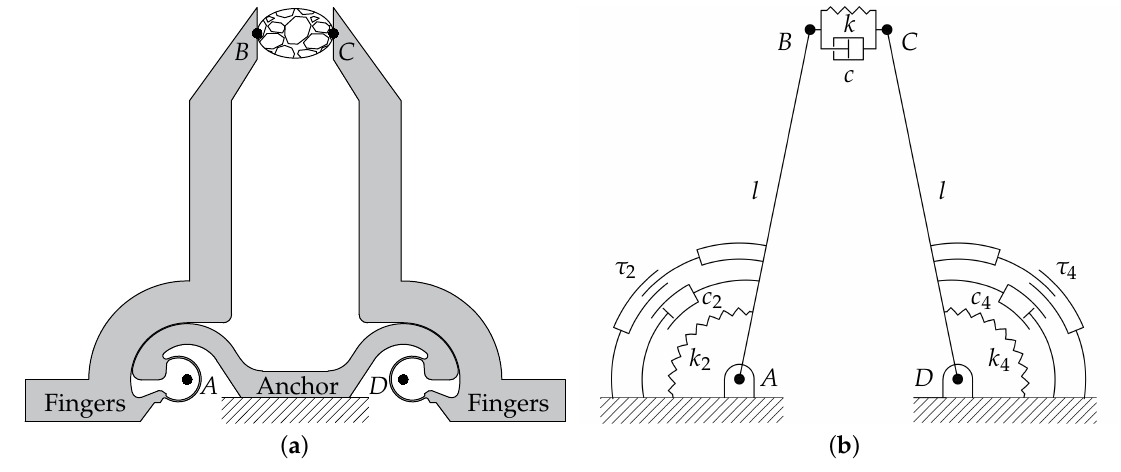
Figure 2. Schematic representations of the microgripper: compliant mechanism ( a ) and corresponding pseudo-rigid body model ( b ).